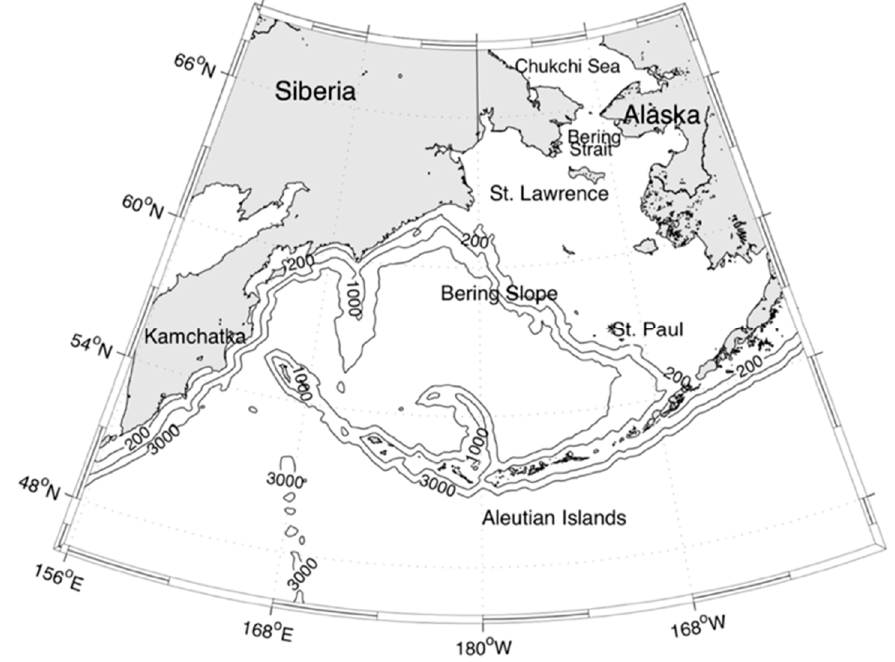
Figure 1. The numerical model domain. The contours are water depths of 200 m, 1000 m, and 3000 m, respectively.